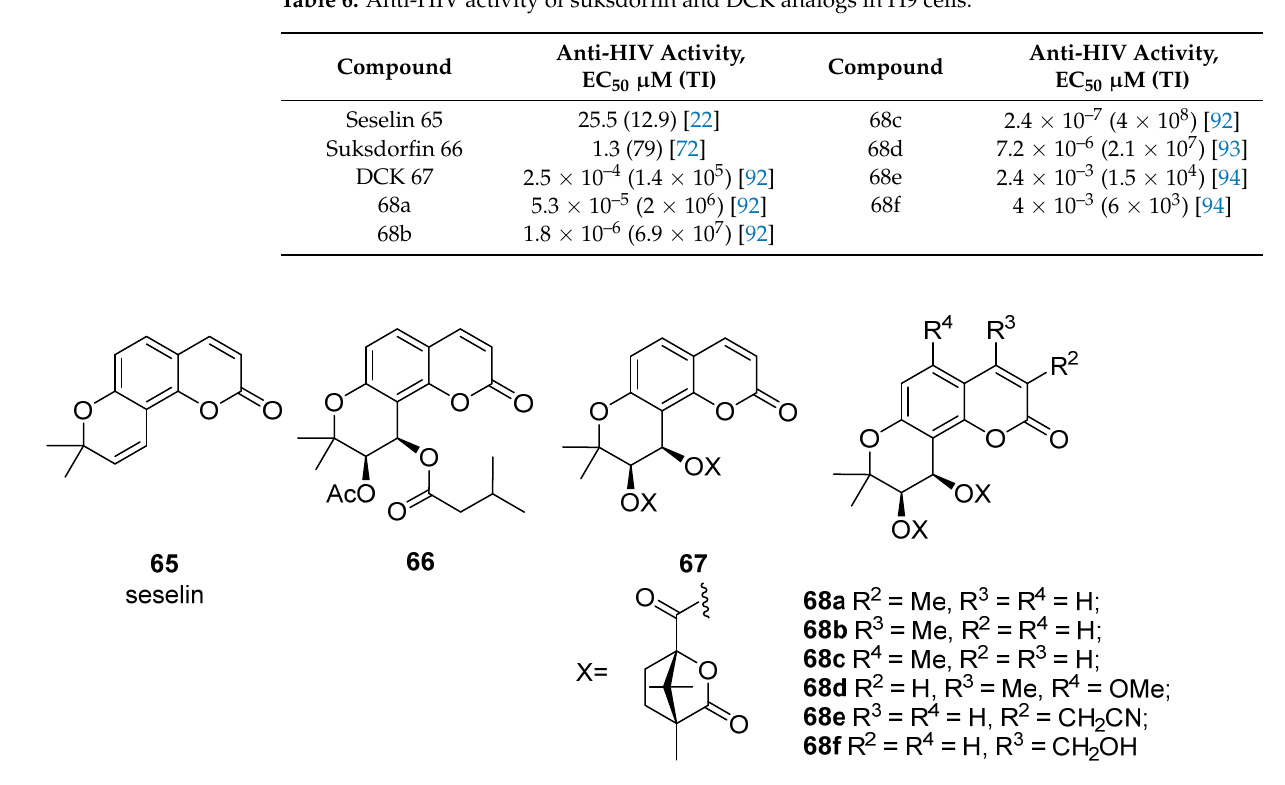
Figure 12. Structures of seselin 65, suksdorfin 66, DCK 67, and its analogues